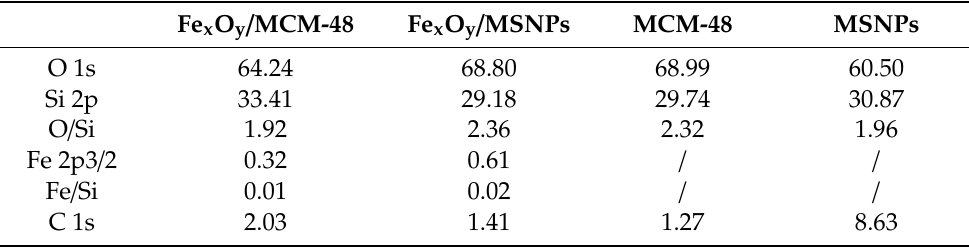
Table 1. Atomic composition (at. %) and atomic ratio from XPS for the Fe x O y / MCM-48 and Fe x O y / MSNPs samples, compared with pure MCM-48 and